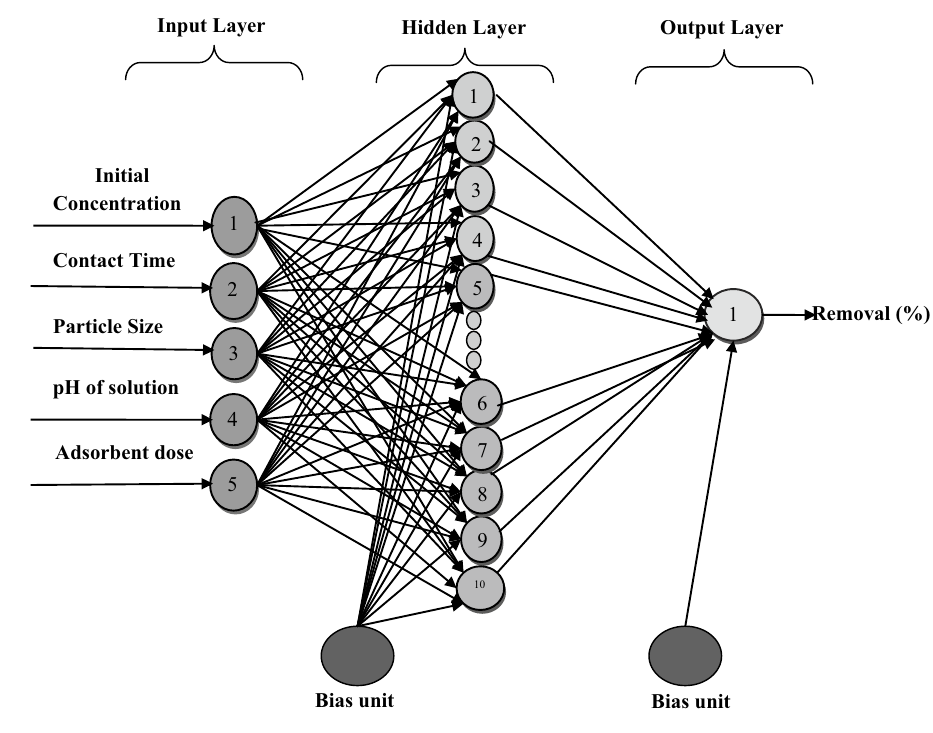
Fig. 1 A schematic diagram of artificial neural network (ANN) for predicting removal (%)